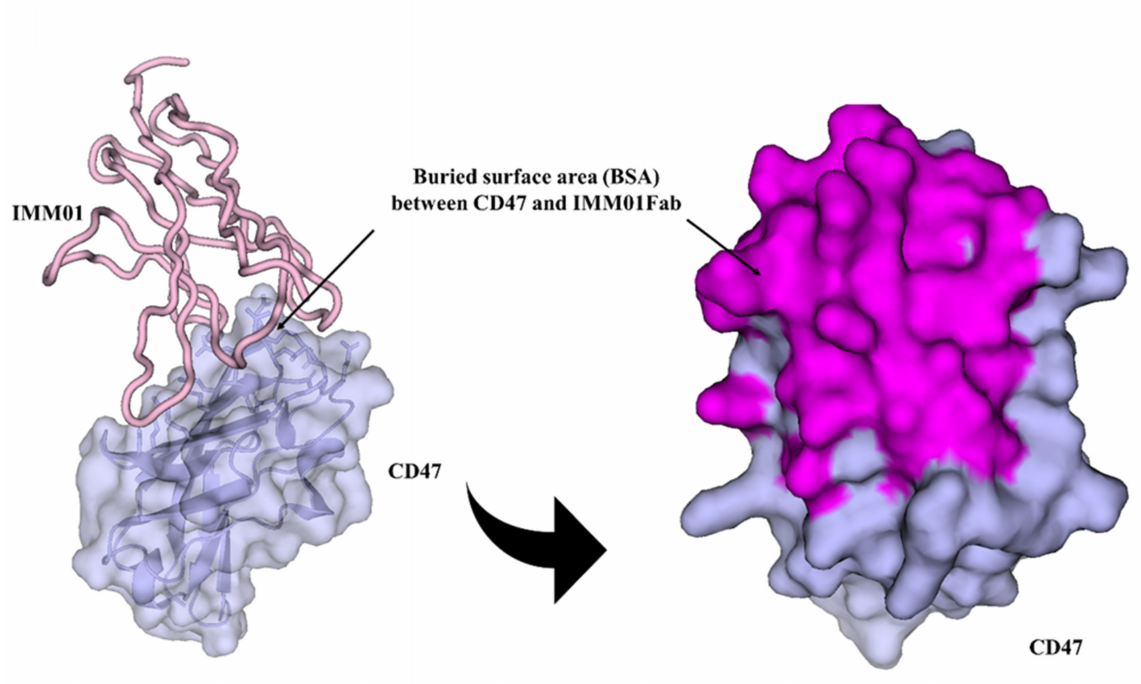
Figure 8. Buried surface area (BSA) between chain A (IMM01) and chain C (CD47). Chain A and chain C are shown in pink and light blue, respectively. The CD47 is shown as surface, and the interfacing residues are highlighted in